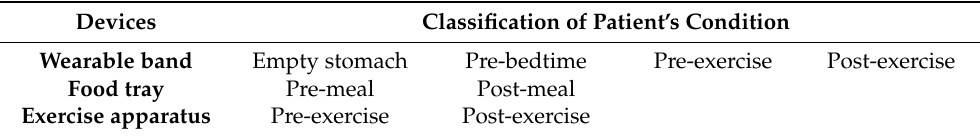
Table 3. Classification of patient’s condition for self-monitoring blood glucose (SMBG). Devices Classification of Patient’s Condition Wearable